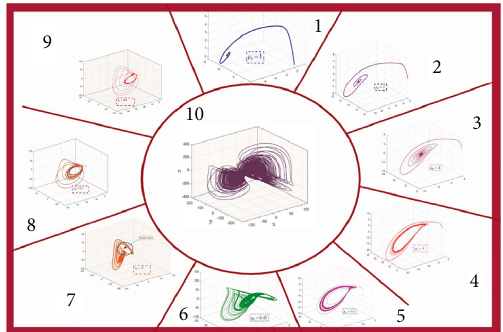
Figure 2: Existence of chaos in clockwise and anticlockwise